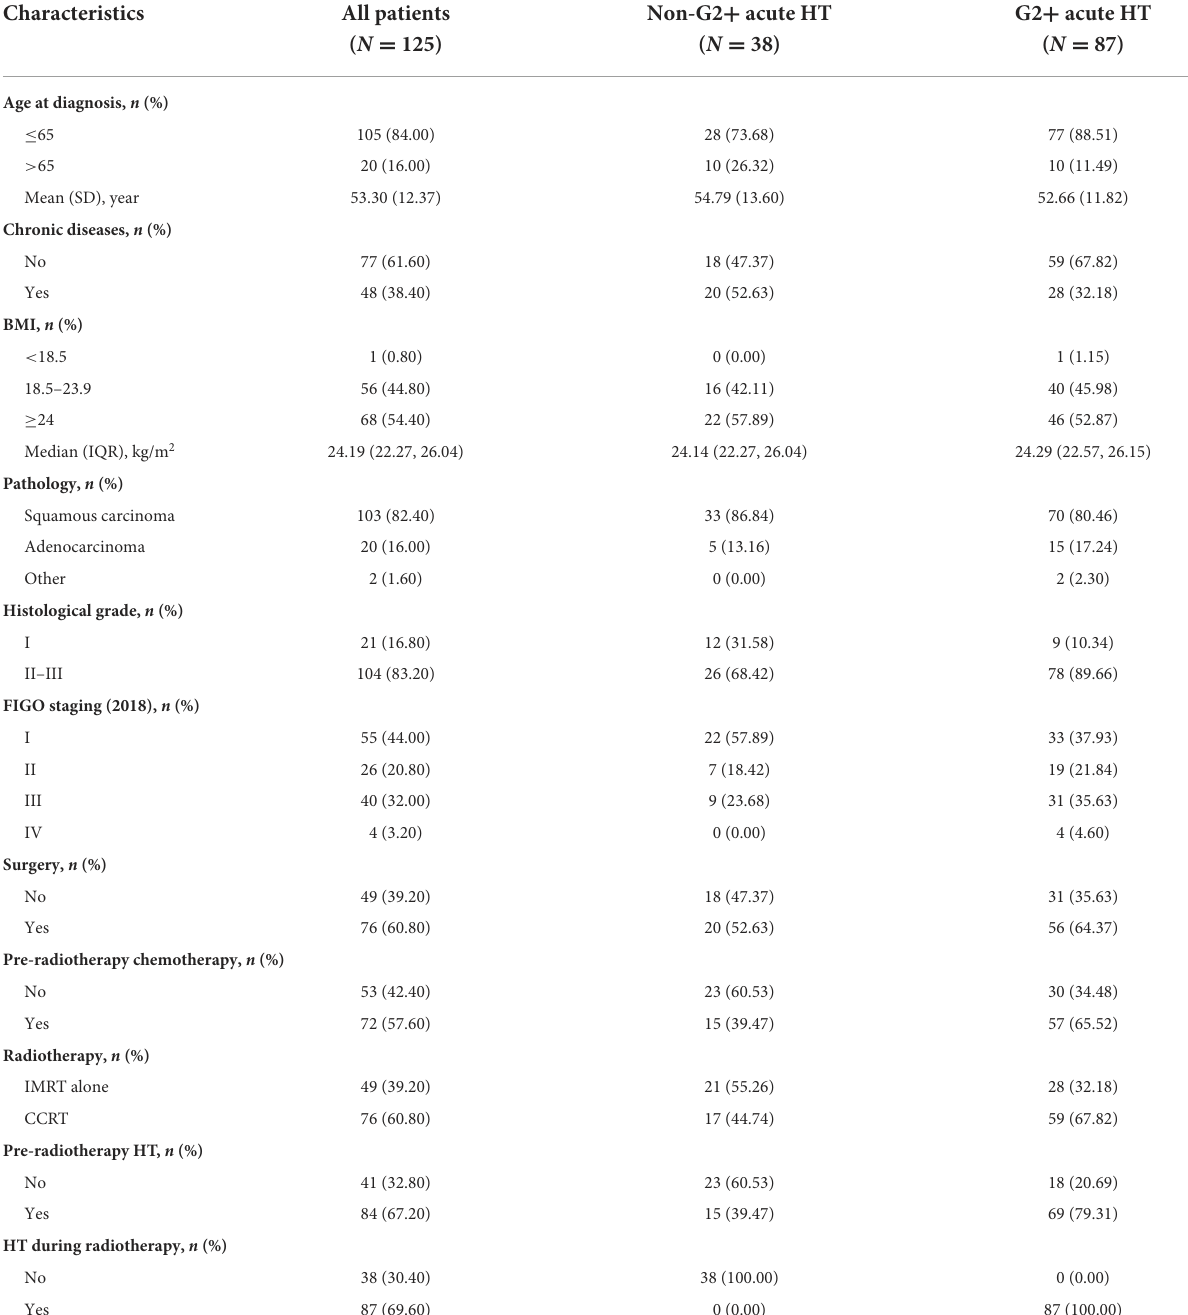
TABLE 1 Clinicopathological characteristics of the patient ( N =